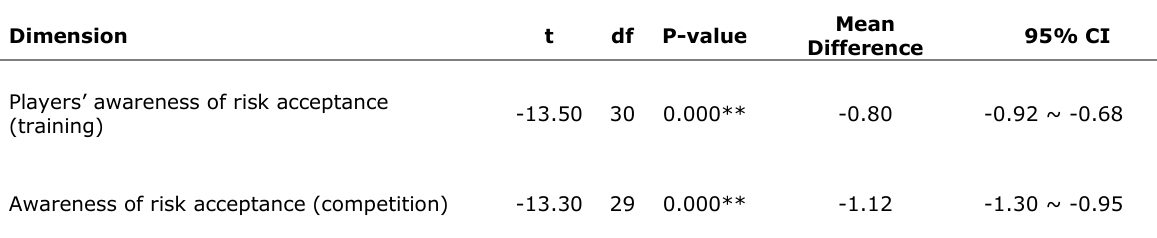
Table 5. Compared means with the same dimension in NOSACQ-50